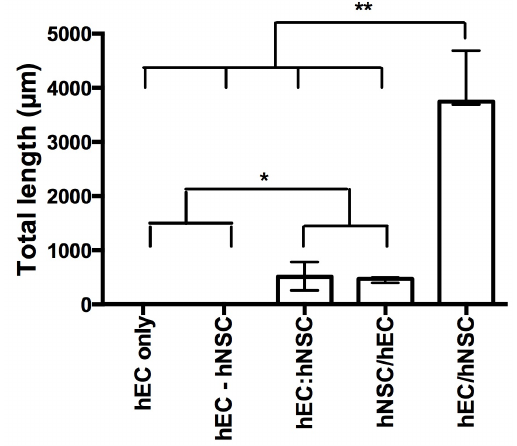
Figure 5. Comparison of efficiency to form vasculature-like structures. Total length of VLS in hCMEC/hNSC coculture was more efficient than any of the other culture conditions, including hCMEC monoculture (hCMEC only), the transwell coculture (hCMEC-hNSC), seeding of hCMECs and hNSCs simultaneously (hCMEC:hNSC), and seeding hCMECs on differentiated hNSCs (hNSC/hCMEC). Data points on the graph represent the median with bars reflecting the value range (post-hoc pairwise comparisons: * p , .05; **p ,